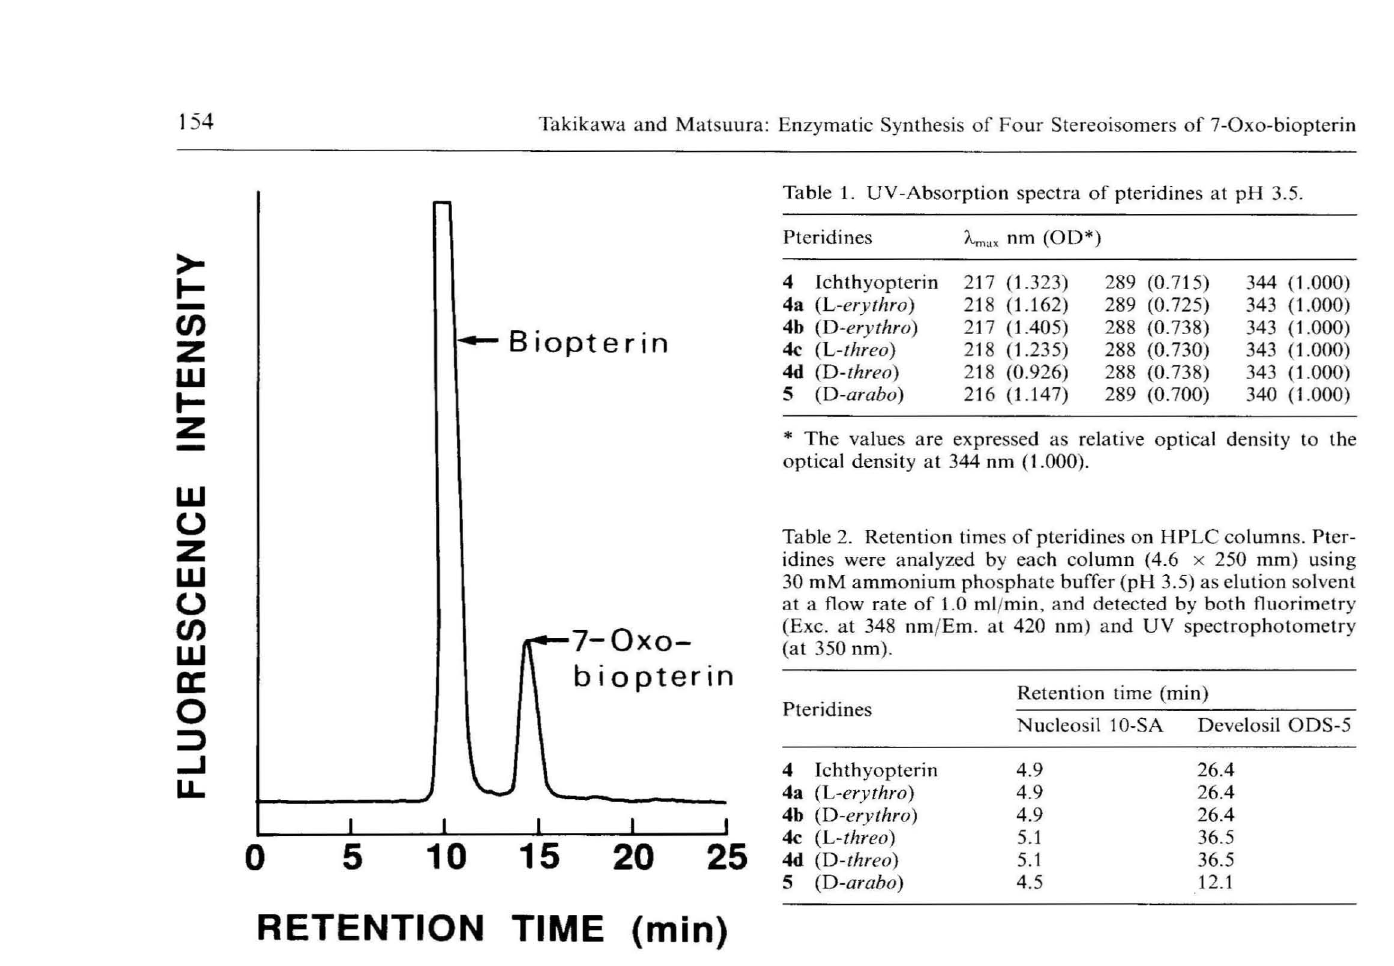
* The values are expressed as relative optical density to the optical density at 344 nm (1.000).